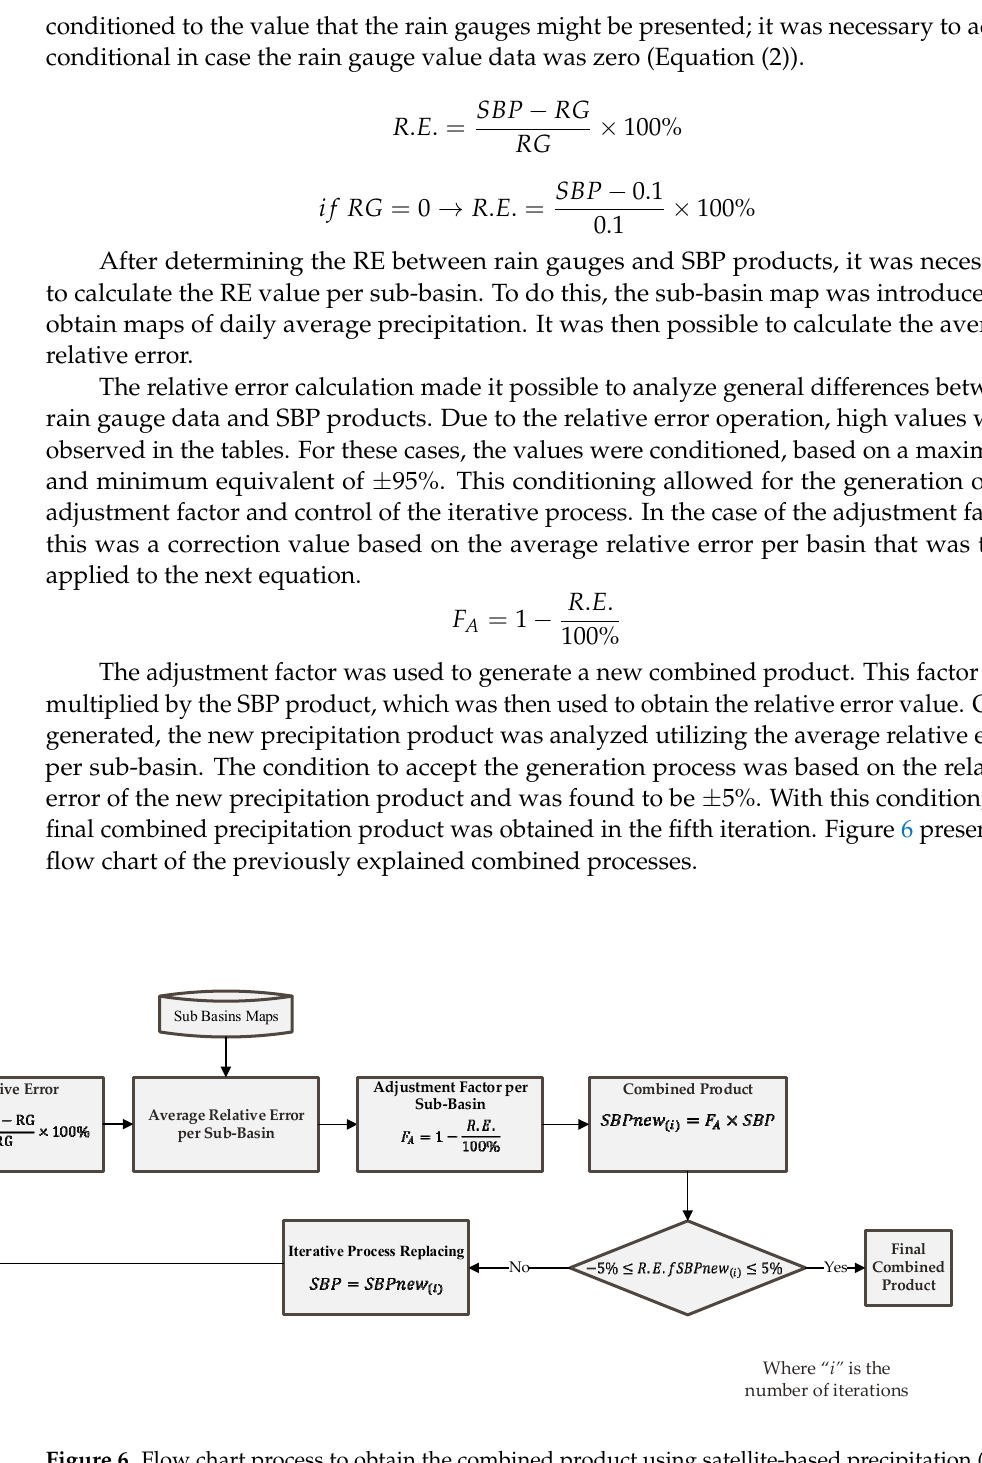
Figure 6. Flow chart process to obtain the combined product using satellite-based precipitation (SBP) and the rain gauge network. Source: Adapted from Ureña, Saavedra and Kubota [43].